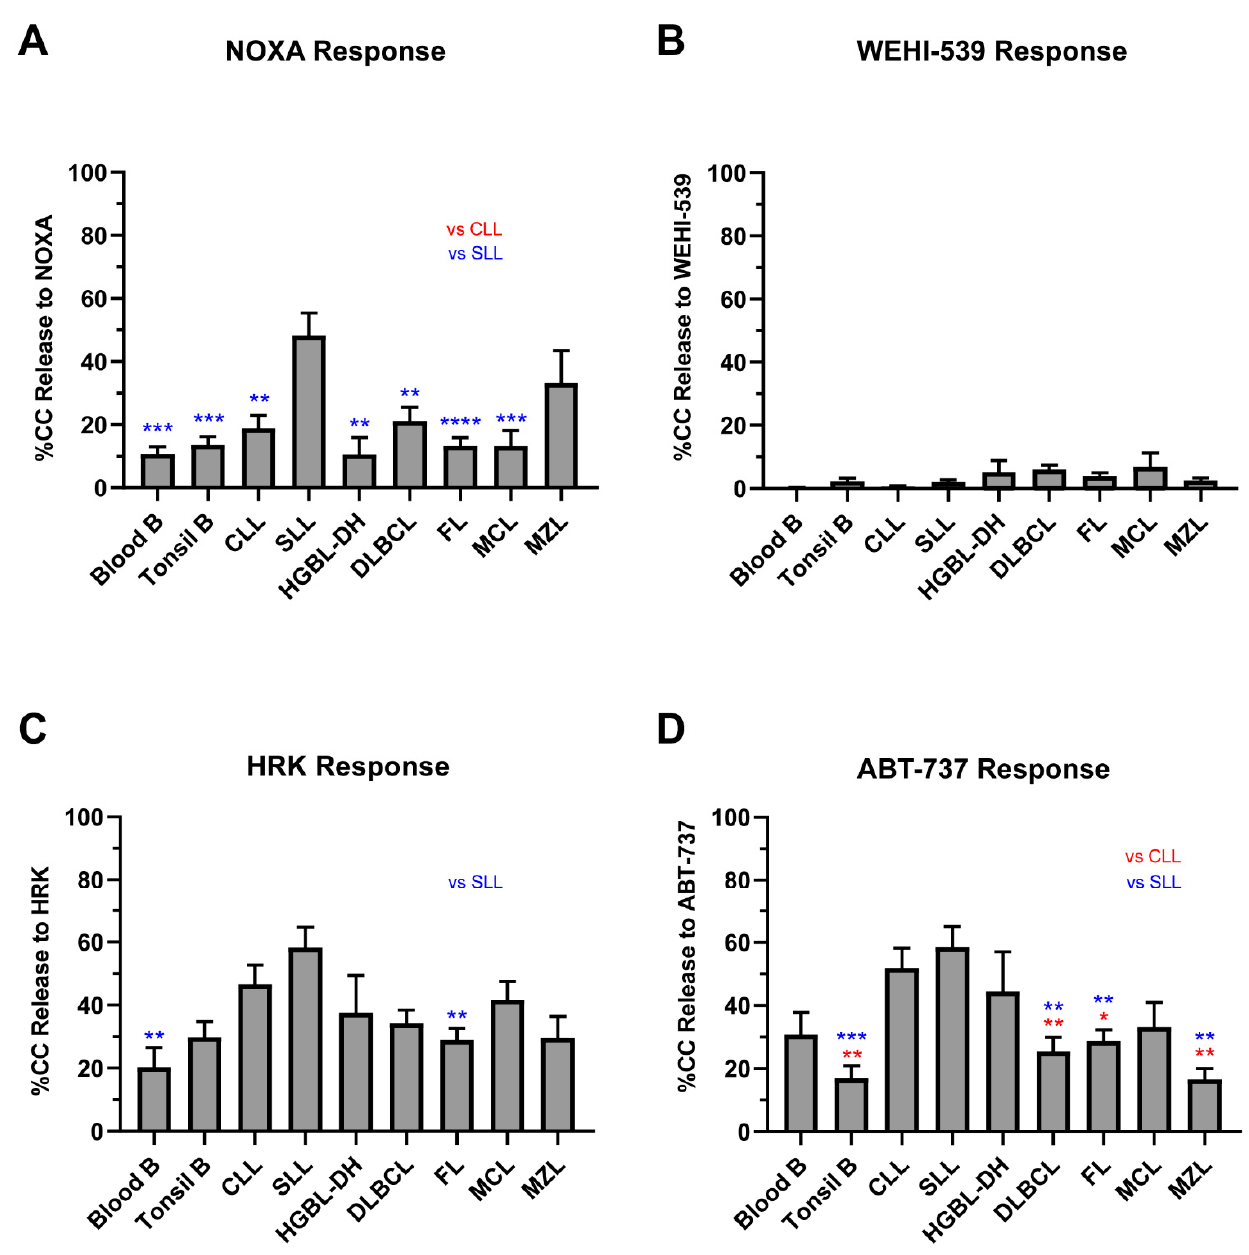
Figure 6. BCLXL and other anti-apoptotic protein dependency. Graphs show cytochrome c release after 90-min exposure to 100 µ M of NOXA ( A ), 1 µ M of ABT-737 ( B ), 1 µ M of WEHI-539 ( C ), and 100 µ M of HRK ( D ) in all NHL subtypes. Bars measure the mean of all samples; error bars indicate standard error of the mean (SEM). A one-way ANOVA with Tukey multiple comparison was used to determine statistical significance between subtypes. NHLs respond poorly to the singular inhibition of anti-apoptotic proteins but respond better when multiple proteins are targeted. BCLXL contributes only modestly to cell survival in our cohort. * p < 0.05, ** p < 0.01, *** p < 0.001, **** p < 0.0001.